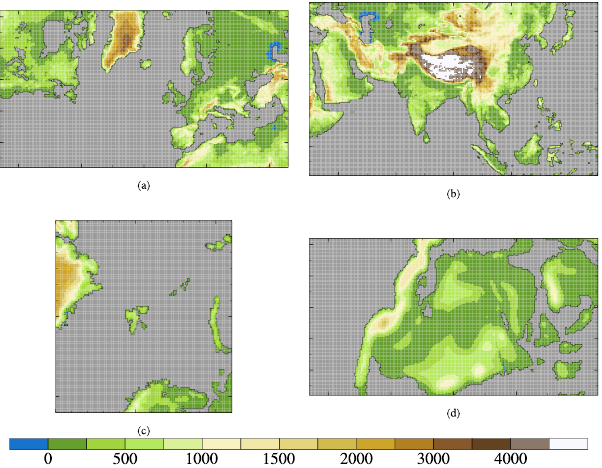
Figure 1. Land–sea mask and orography (sea coloured grey, land height in metres) for four configurations of HadRM3B. (a) shows the standard European domain at 0.44 ◦ resolution, (b) shows the equivalent domain for East Asia, (c) shows a configuration for the Arctic and Svalbard at 0.22 ◦ (as used in Day et al., 2012), and (d) a North America/European configuration for the early Cretaceous at 0.44 ◦ resolution (as used in Haywood et al.,